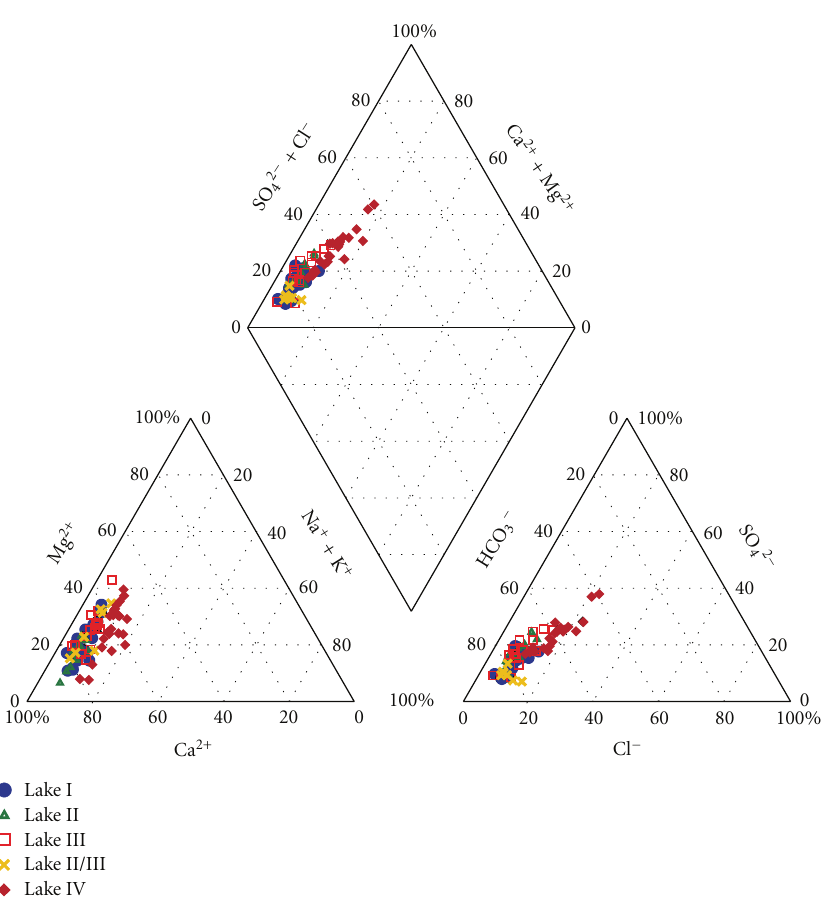
Figure 4: Piper diagrams showing chemical composition of water in tundra lakes I, II, III, II/III, and IV, the vicinity of Petuniabukta.